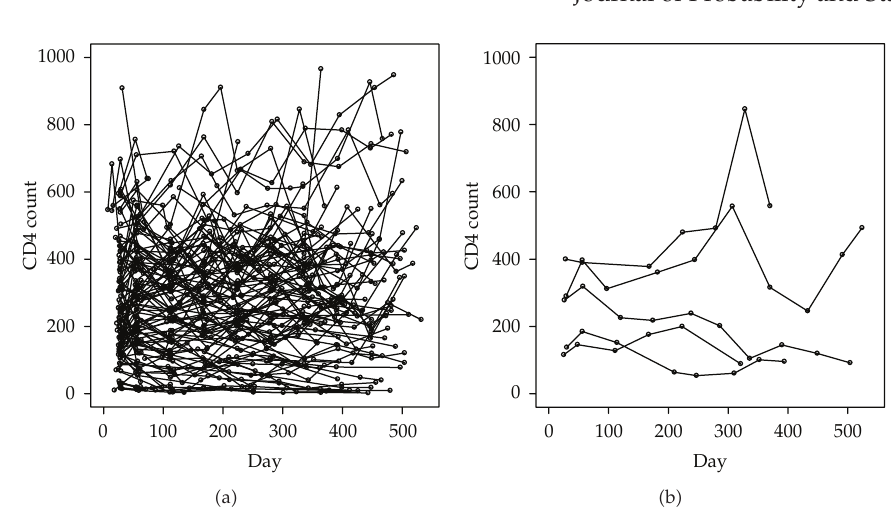
Figure 1: CD4 measurements over time. (cid:2) a (cid:3) All subjects. (cid:2) b (cid:3) Five randomly selected